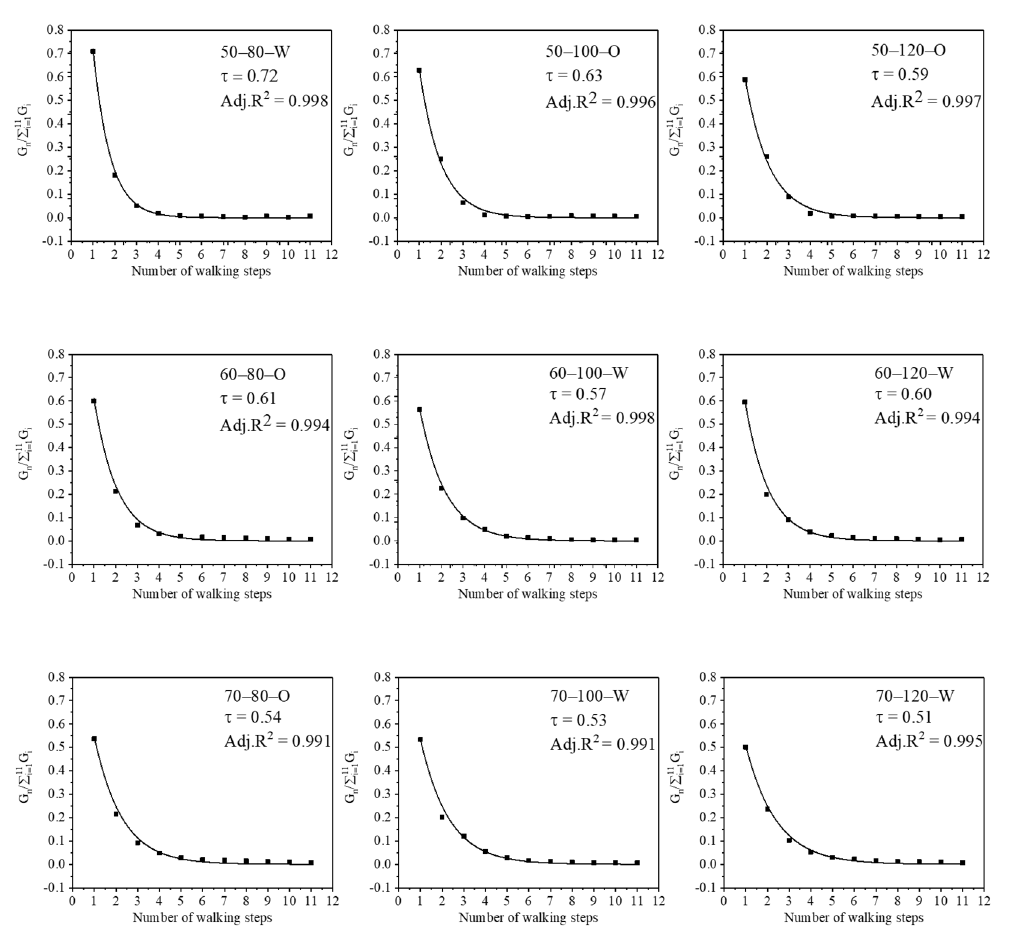
Figure 7. Fitting results for the transfer efficiency τ .